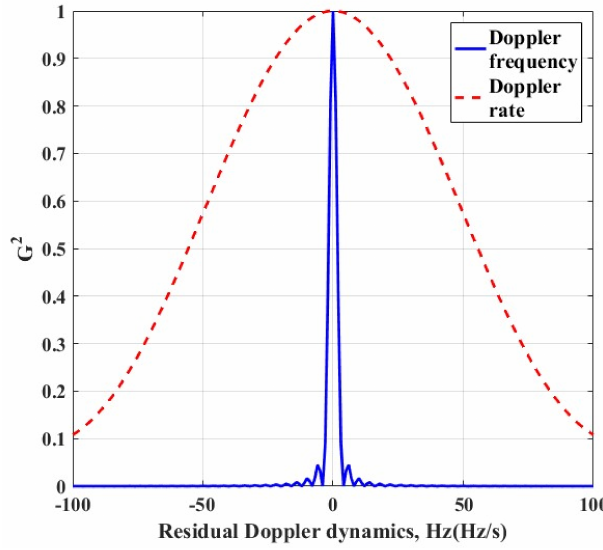
Figure 10. Comparison of coherent loss between residual frequency and residual frequency